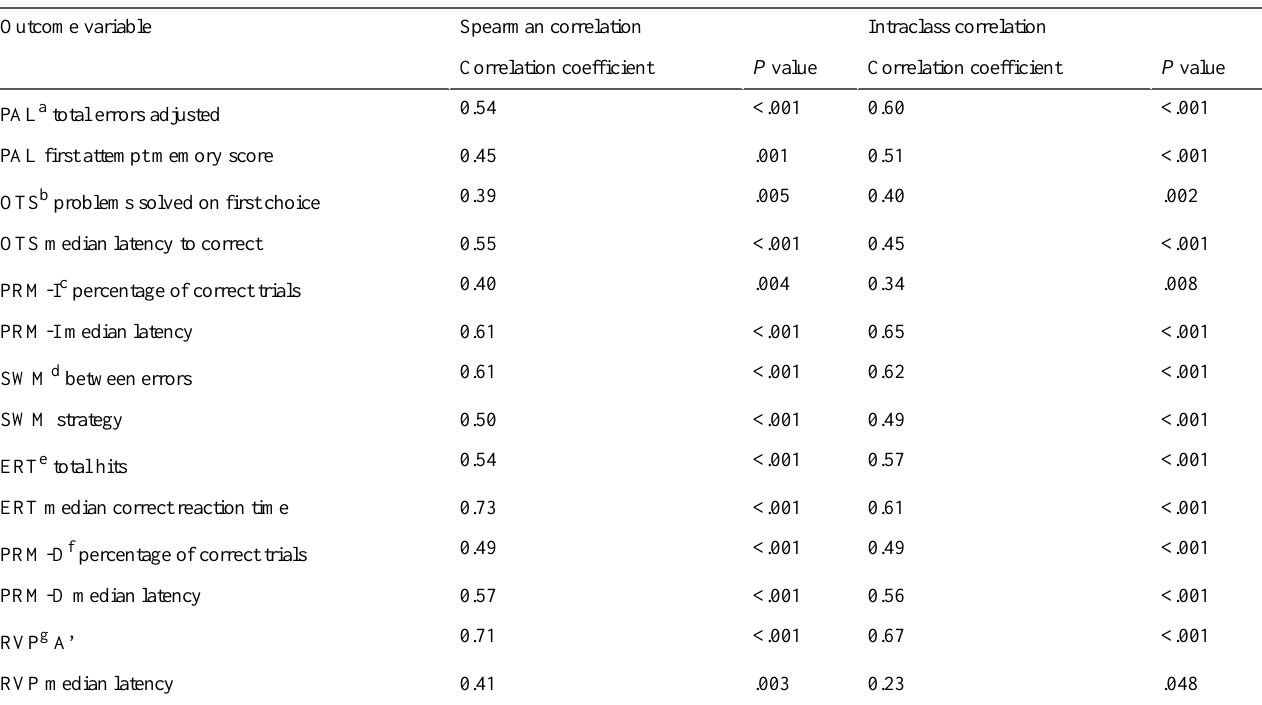
Table 1. Reliability analysis for outcome measures of Spearman correlation coefficients and intraclass correlations between test results obtained in-person and in web-based